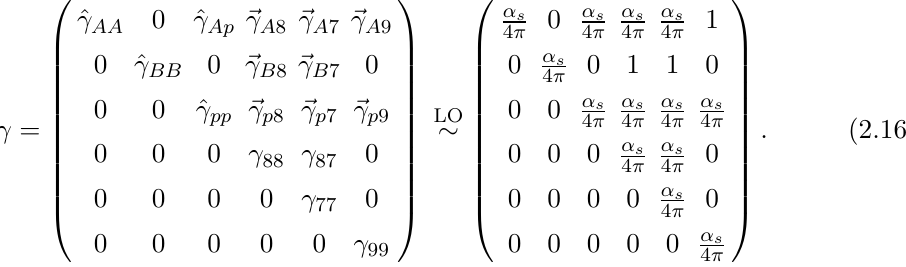
the de(cid:12)nitions of Q hand, some of the elements of ~(cid:13) accompanying factor of (cid:11)